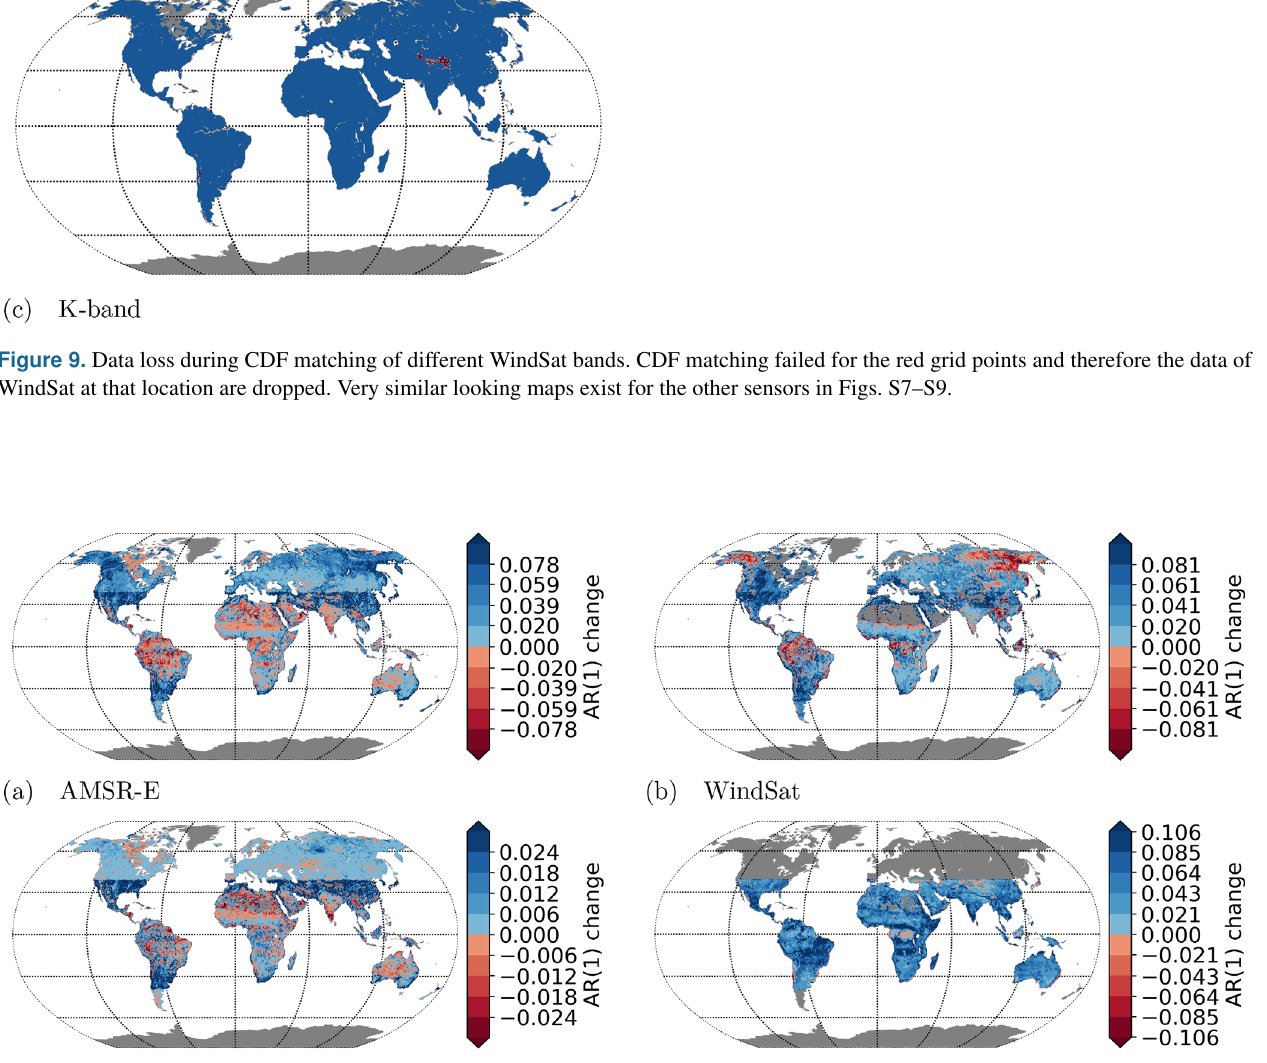
Earth Syst. Sci. Data, 12, 177–196,